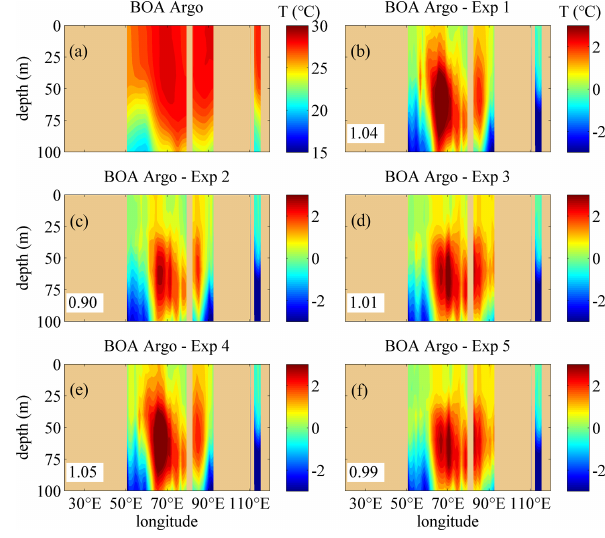
Figure 11. The same as Fig. 10, but along 7.5 ◦